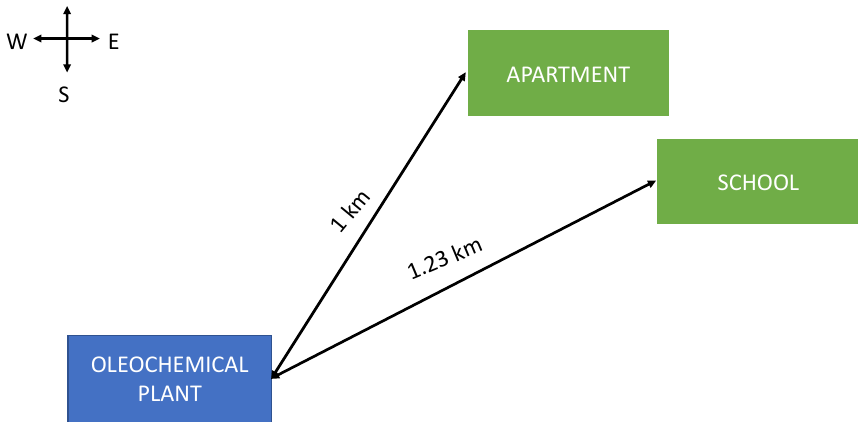
Figure 5. Schematic drawing of location studied.